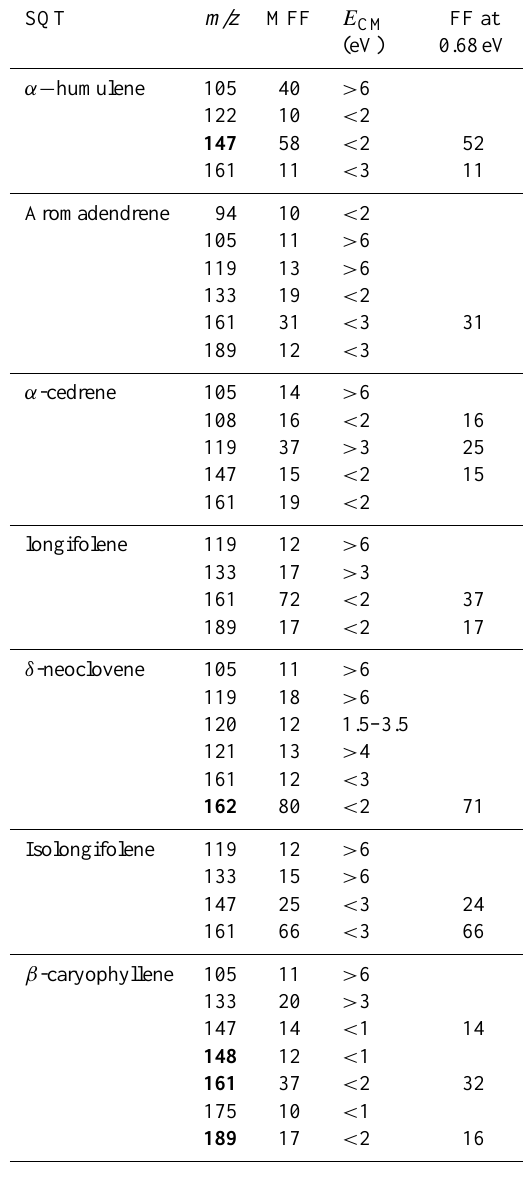
Table 2. Fragment ions from the fragmentation of SQT molecular ions ( m/z 204). In bold, NO + /SQT product ions observed in SIFT- MS (Dhooghe et al., 2008). MFF=Maximum Fragmentation Frac- tion; FF=Fragmentation Fraction at 0.68eV. E CM (eV) indicates the range of E CM where MFF is